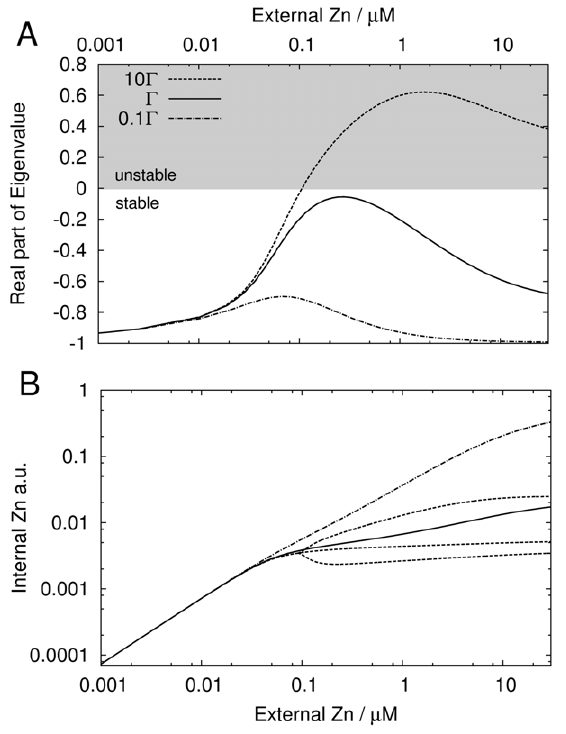
Figure 7. Plant roots: Robustness and stability. Robustness and stability of the activator-inhibitor model for 0 : 1 C (dash-dotted), C (solid) and 10 C (dashed) and varying external zinc concentration. A, real part of largest eigenvalue. B, internal zinc concentration. Minimal and maximal values of limit cycle shown for unstable steady state ( 10 C ).